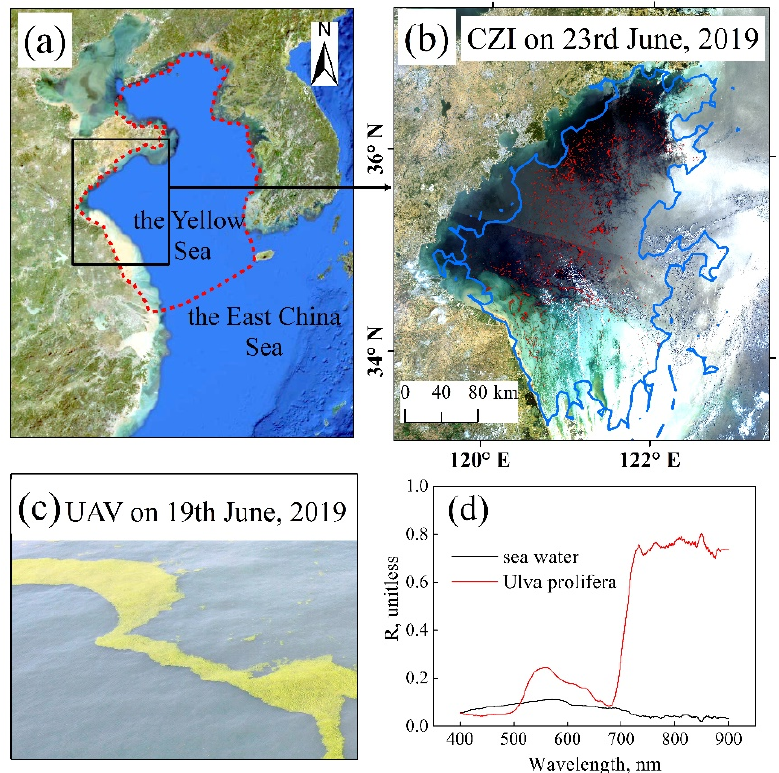
Figure 1. ( a ) Location of the study area; ( b ) The HY-1C CZI true color composite of band3 (red), band2 (green) and band1 (blue) acquired on 23 June 2019; ( c ) UAV photo of green tide of Ulva prolifera on 19 June 2019 (by Qianguo Xing); ( d ) The reflectance of sea water and Ulva prolifera measured on 19 June 2019 (by Bo Jiang and Hailong Liu).